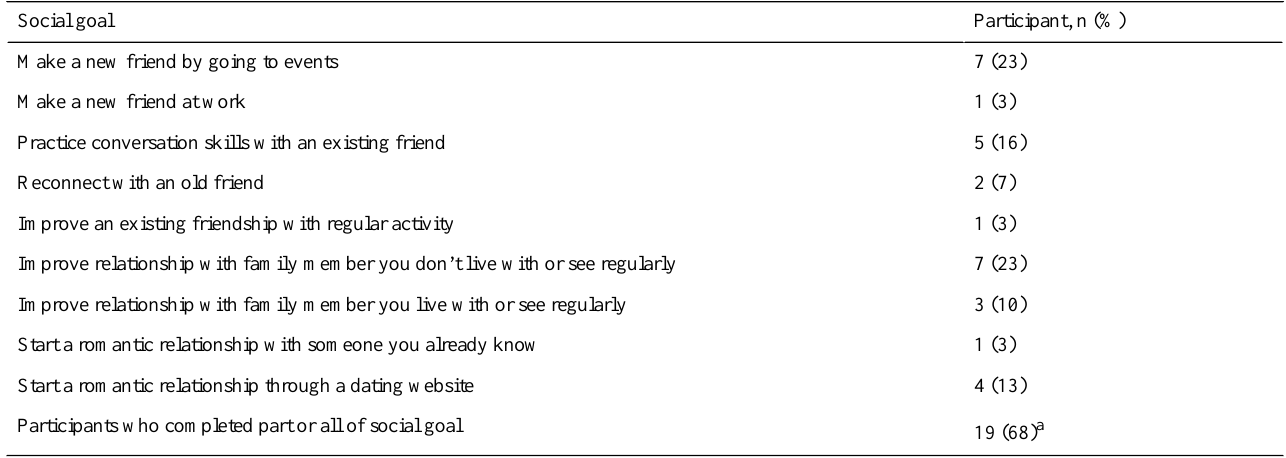
Table 2. Social goals selected and number completed (consider putting goals in order of most to least common;